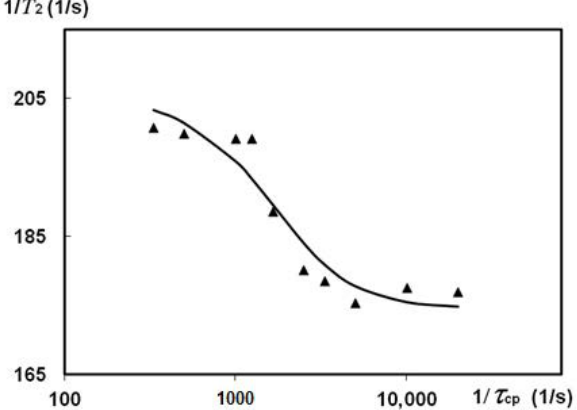
Figure 11. The transverse relaxation rate R 2 measured (T = 300 K) in CPMG experiments on oriented (0 ◦ to static magnetic field B 0 ) silk fibres B. mori at HL = 0.60 (black, triangles) varying τ cp . The data were fitted by the R 2 expression established within two site-exchange theory in the case of fast ( k ex > ∆ ω ) exchange [58–62]. Solid line is the fit of the obtained data to the expression: R 2 = R 2 0 + ( ϕ / k ex ) [1 − tanh( k ex τ cp /2)/( k ex τ cp /2)] with R 2 0 = 174.6 s − 1 , k ex = 5 793 s − 1 , ϕ / k ex =3 2.4, P c = 0.8, ϕ = P c (1 − P c ) ∆ ω 2 parameters. P c is the fractional population of the protons in site C, whereas a population of site D was described as (1 − P c ). Other details and parameters are provided in the